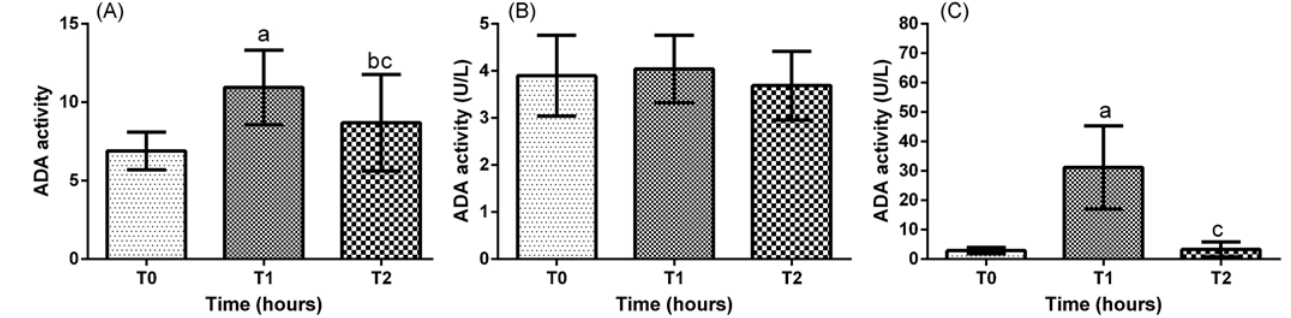
FIGURE 1 – Adenosine deaminase activity. (A) Serum ADA activity; (B) ADA activity in saliva; (C) ADA activity in urine. Data are expressed as means ± SD or median. The data were processed by analysis of variance (One-Way - ANOVA), followed by the Tukey test or Kruskal-Wallis test, followed by the Dunn test. T0: before the exercises are performed; T1: 60 minutes after physical exercises; T2: 24 hours after physical exercises. a p<0.0001 when compared to T0. b p<0.05 when compared to T0. c